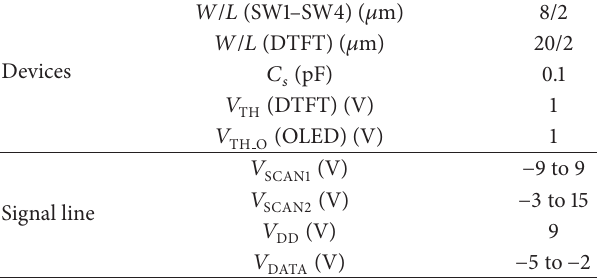
Table 1: Simulation parameters of the proposed circuit.